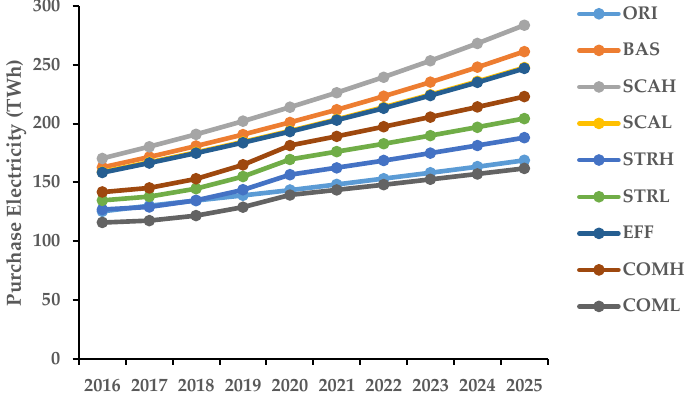
Figure 9. External purchased electricity under different scenarios.